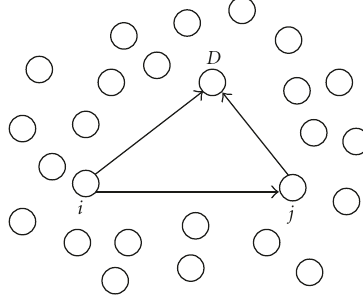
Figure 1: Wireless cooperative